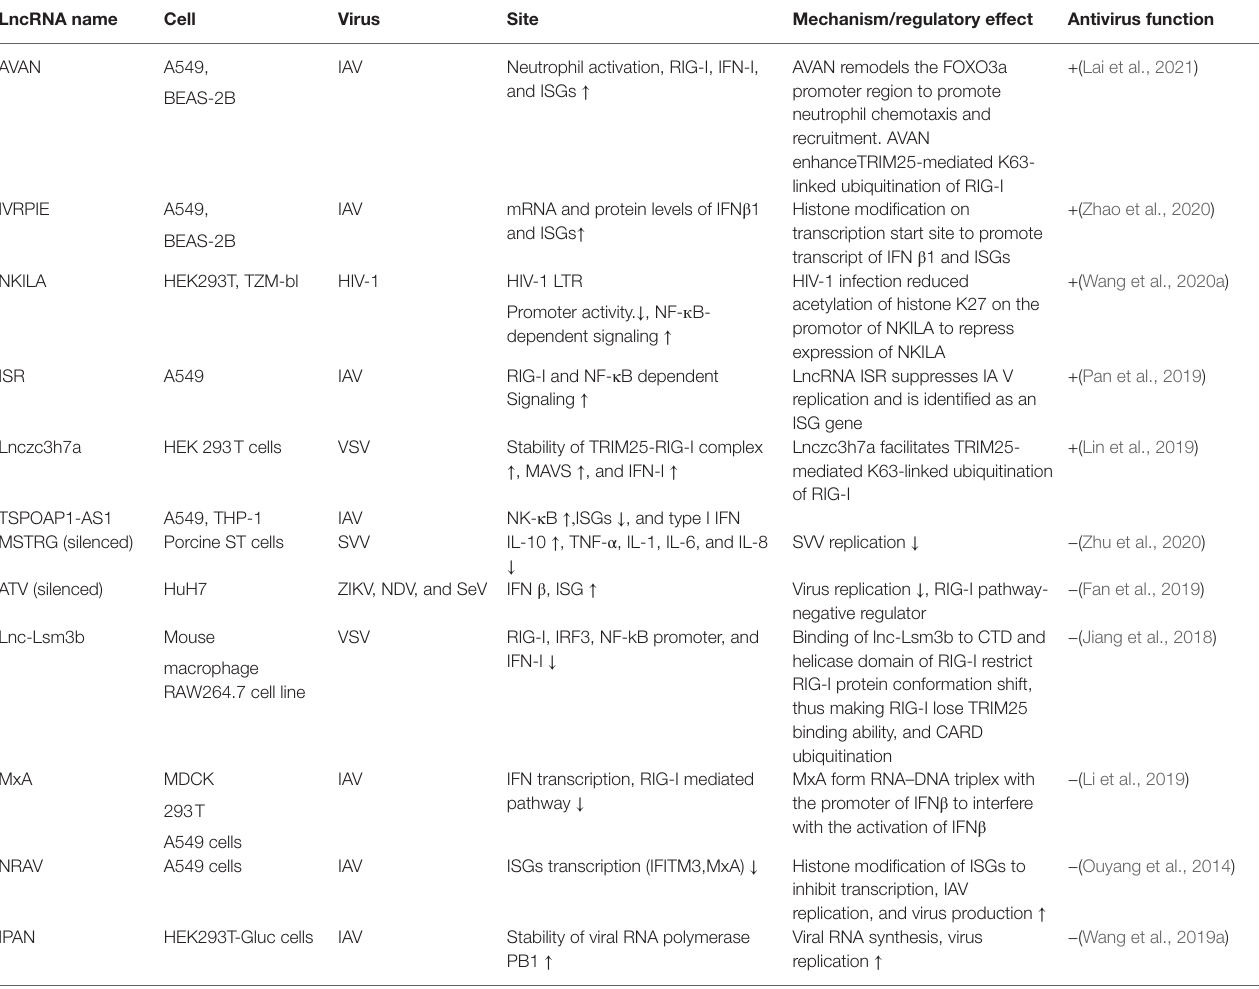
TABLE 2 | The role of lncRNA in antiviral innate